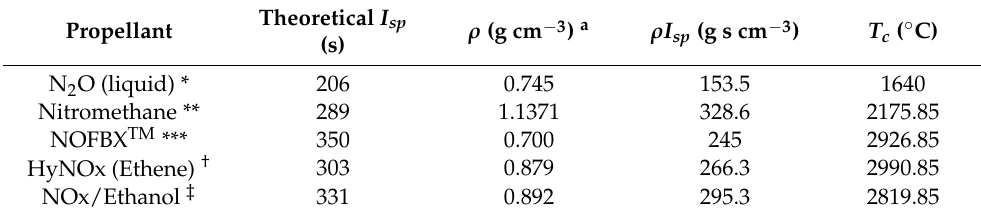
Table 6. Ideal (vacuum) performance and physical properties of the Liquid NOx Monopropellants class (compounds and premixed fuel